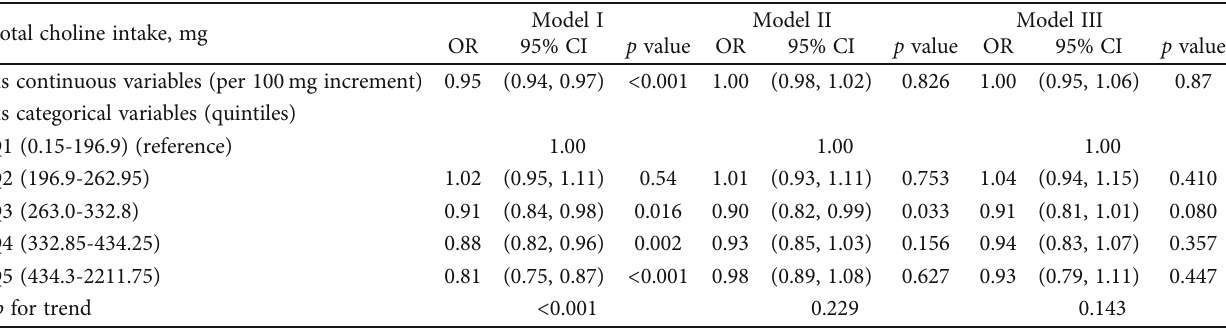
Table 2: Logistic regression of total choline intake with odds of hypertension.